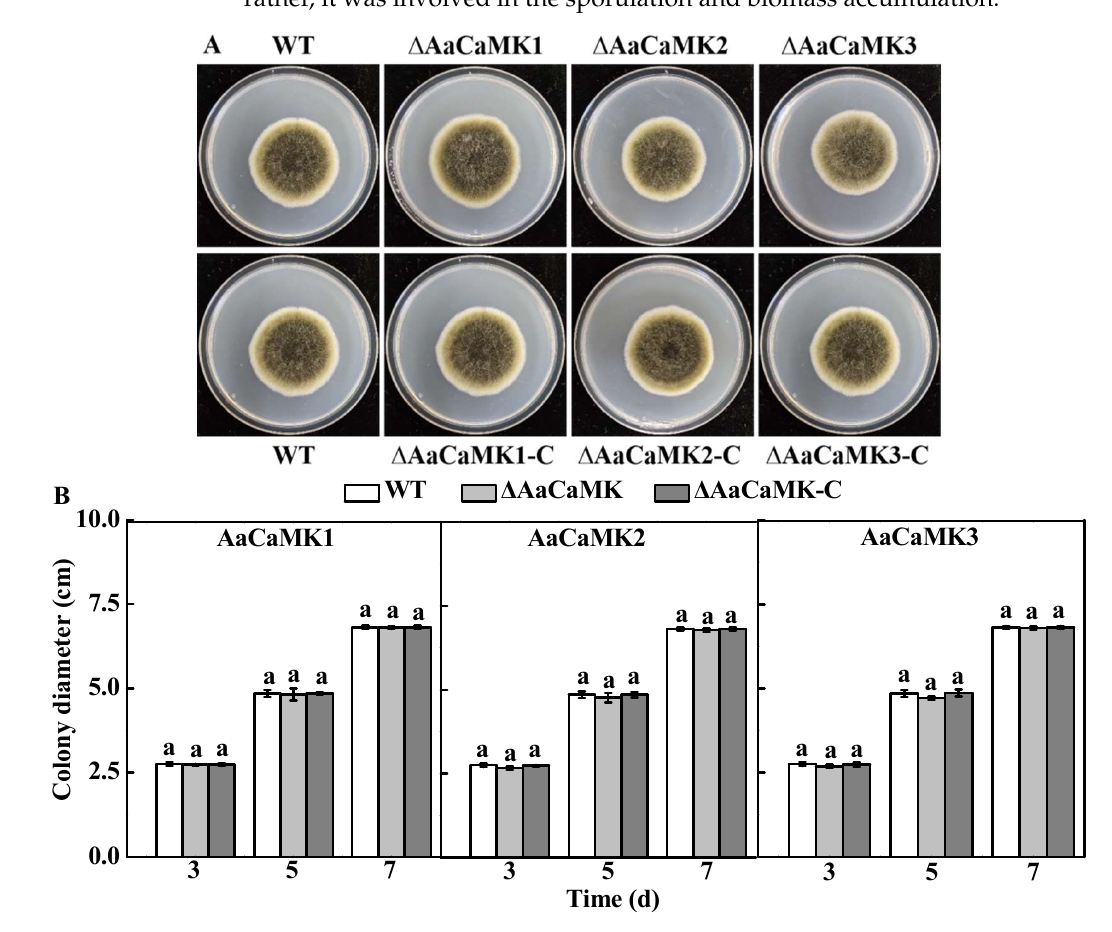
Figure 1. The colony morphology ( A ) and growth rates ( B ) of A. alternata on PDA medium 5 d after incubation at 28 ◦ C. Vertical lines indicate the standard error ( ± SE) of the means. Different letters indicate significant differences ( p < 0.05).